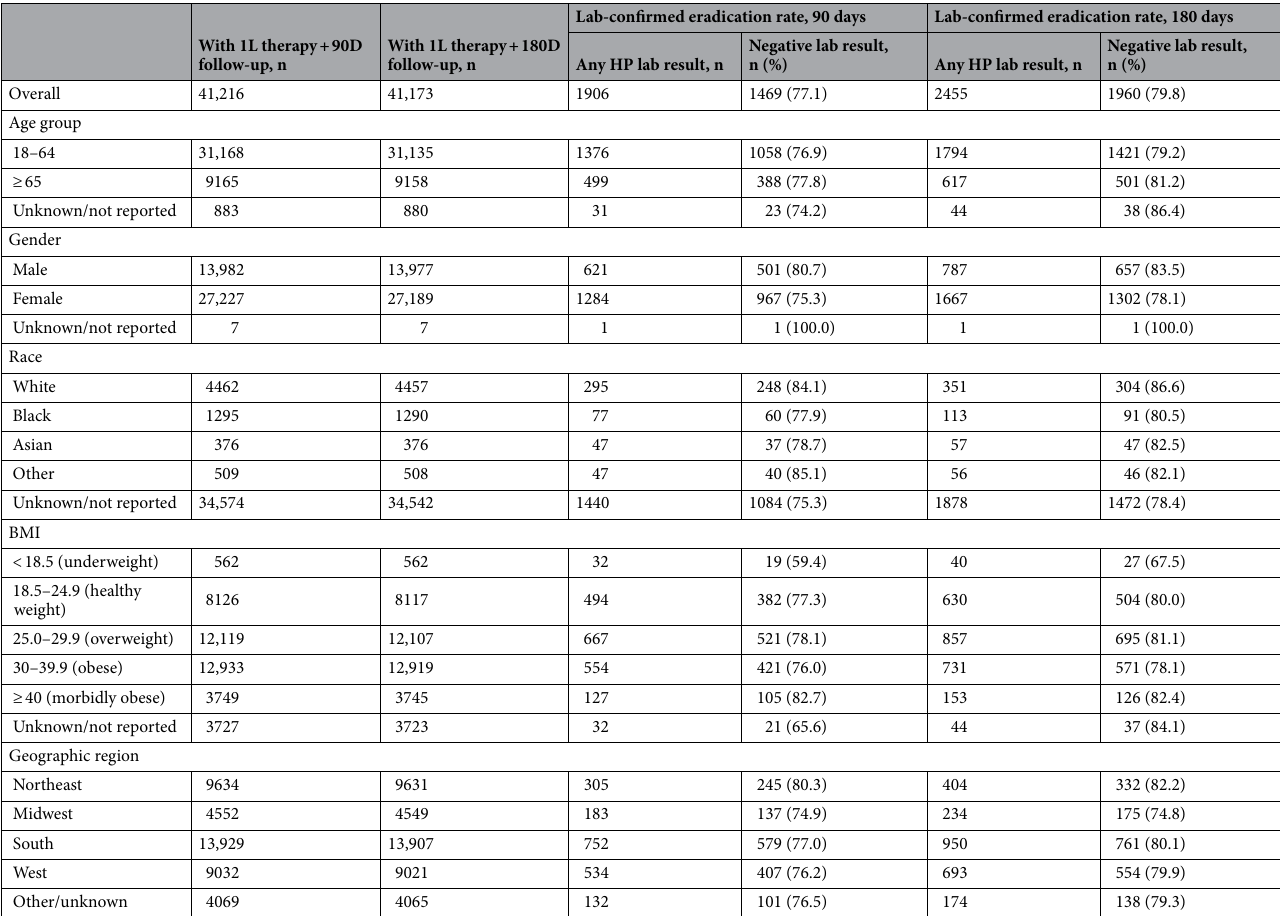
Table 3. Helicobacter pylori (HP) eradication rates after first-line (1L) eradication treatment. BMI, body mass index; D,